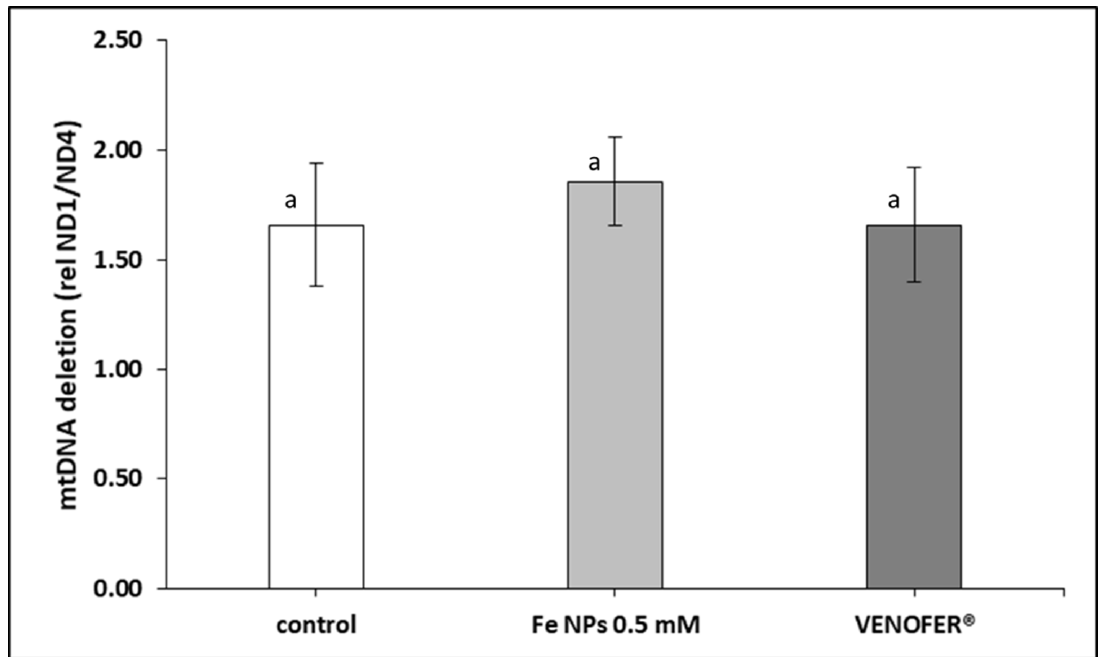
Figure 2. ND1/ND4 mtDNA deletion. Results expressed as mean ± SEM. ( p < 0.05). (a) vs. control ( p < 0.05).